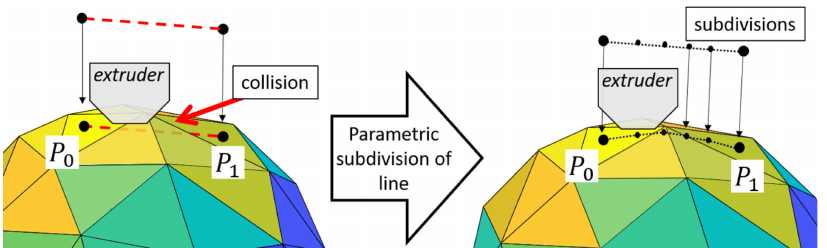
Figure 4. Subdividing a line P 0 − P 1 before projection to avoid collisions and achieve proper printing. The distance between two consecutive points might change after projection since the points might cross the model at different heights (z-values) once it is projected, as shown in Figure 5.